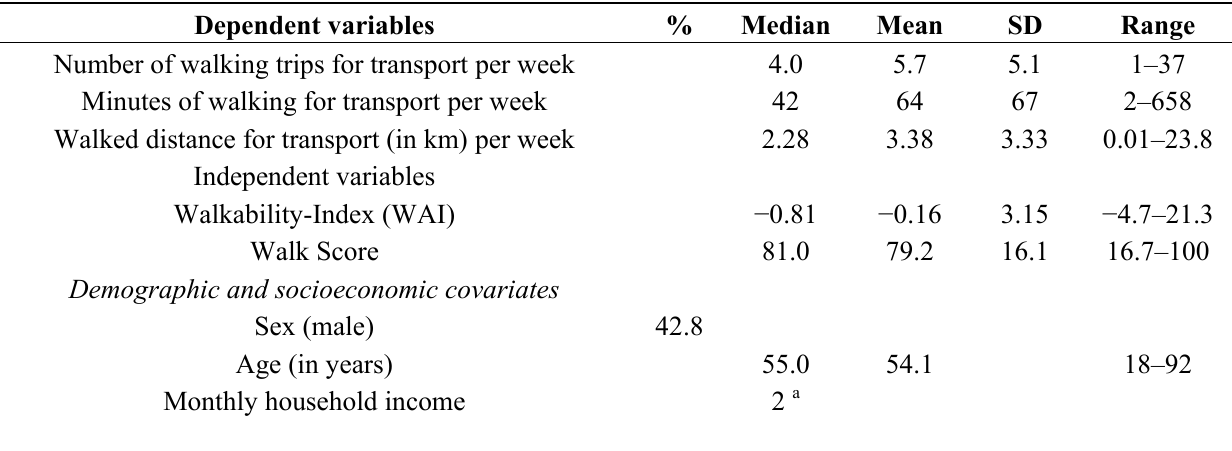
Table 2. Model variables ( n = 1,871) and sample